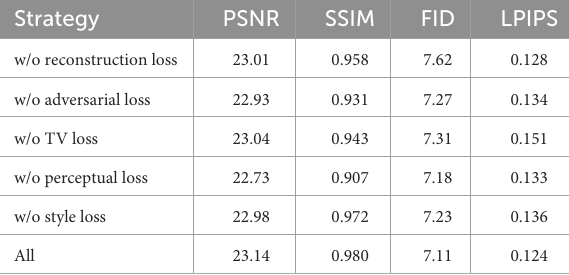
TABLE 5 The ablation of loss functions on the CelebA data